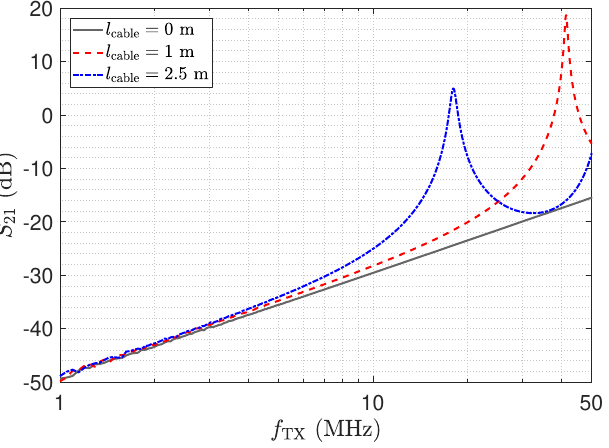
Figure 13. Measurement results for three different cable lengths for the circuit in Figure 10, determined by a network